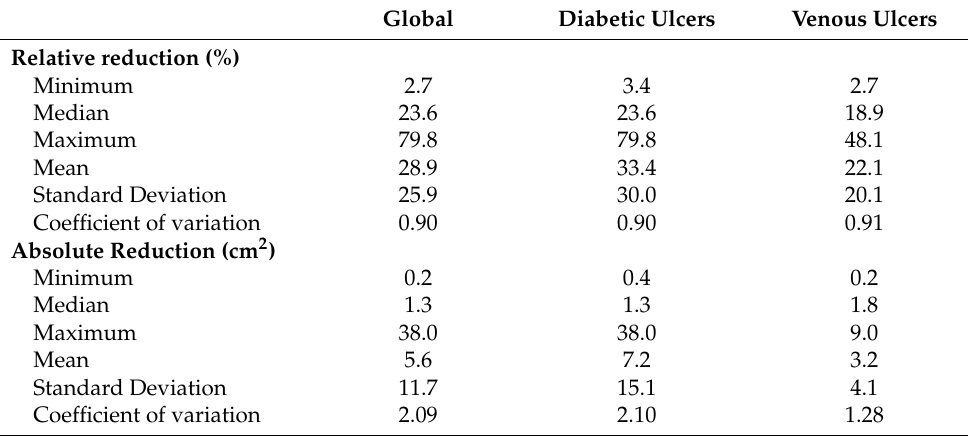
Table 2. The main statistics for the absolute reduction and relative reduction of the ulcer area. Global